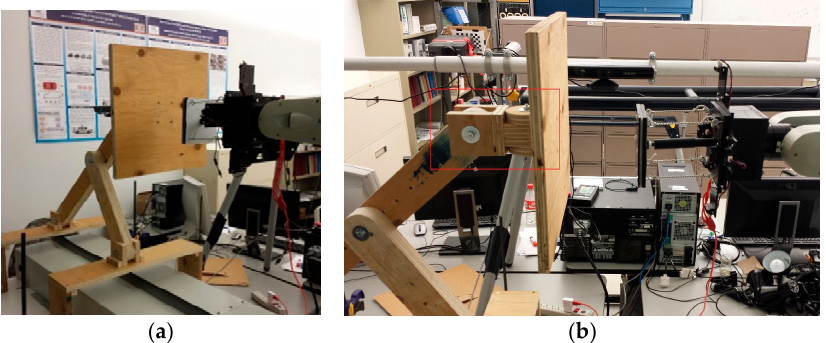
Figure 21. Compliant wrist operating in proximity to a planar surface: ( a ) general configuration; and ( b ) side view evidencing the prescribed gap in between the compliant plate and the surface.